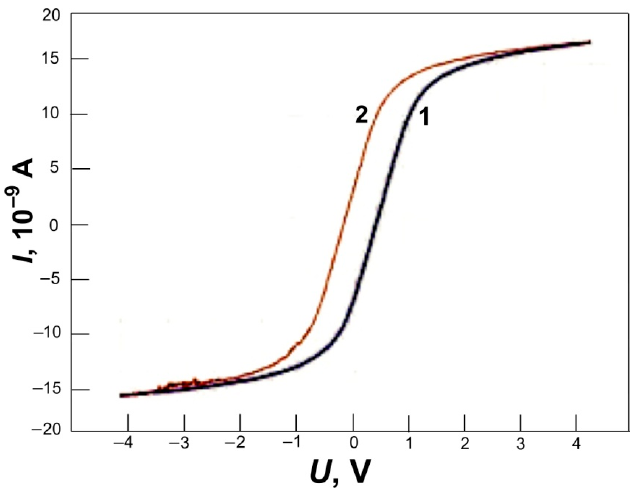
Figure 10. Hysteresis in the I - V curve of shungite (electric force spectroscopy mode of AFM). The curves were measured at one point with an increase in the voltage (curve 1) and with a decrease in the voltage (curve 2).